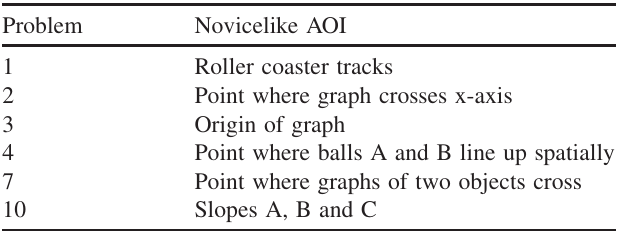
TABLE II. Novicelike AOIs defined based on the most com- mon incorrect student responses in study